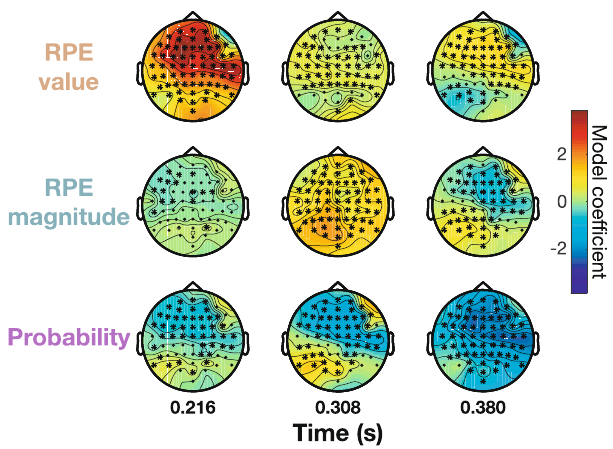
Fig. 3 Spatio-temporal dynamics of prediction errors across ERP scalp topographies. Single-trial regression over all 64 electrodes is computed for three 50 ms windows centered on the largest peak in model coef fi cients for RPE value (216 ms at Fz), RPE magnitude (308 ms at Pz), and probability (380 ms at Fz) from Fig. 2. Stars indicate signi fi cant electrodes ( q FDR < 0.05; n = 32 participants). Valenced RPE value shows a frontal distribution in the early window (top left). Non-valenced RPE magnitude is maximal at posterior electrodes in the middle window (center). Probability is maximal at fronto-central sensors in the late window (bottom right). See Supplementary Fig. 6 for evoked potential voltage